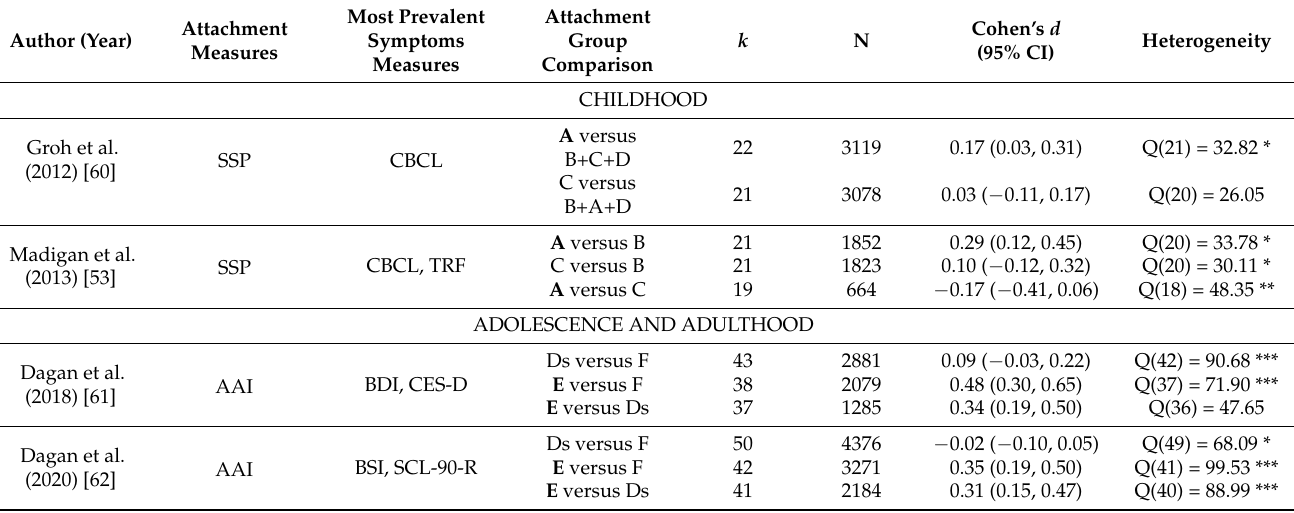
Table 1. List of meta-analyses assessing the magnitude of the links between insecure attachment patterns and internalizing